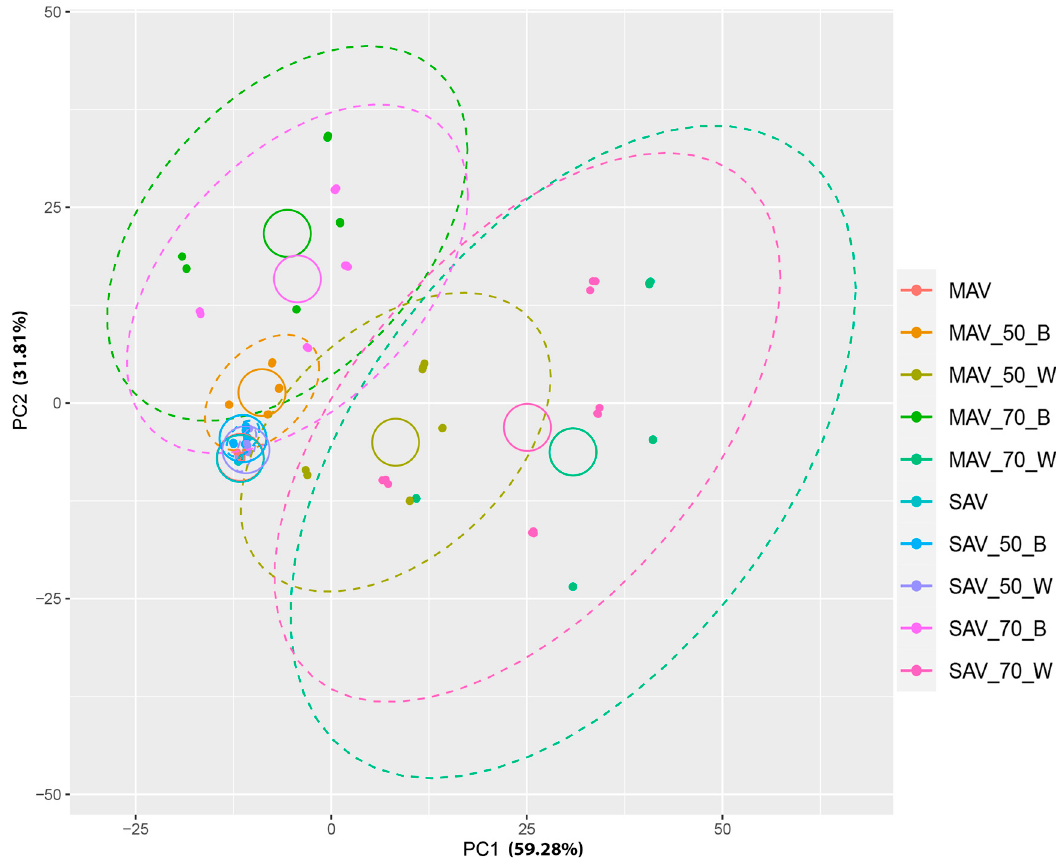
Figure 6. PCoA representing all the color measurements of green patches of the Gretag Macbeth chart with and without adaptor. Ellipses around each type of adaptor indicate the dispersion of the measurements and circumferences encircle the centroids of the distributions of measurements of each adaptor type. Samples were colored according to the used adaptor. MAV, medium area view; SAV, small area view; 50B, 50% reduction with black adaptor; 50W, 50% reduction with white adaptor; 70B, 70% reduction with black adaptor; 70W, 70% reduction with white adaptor.